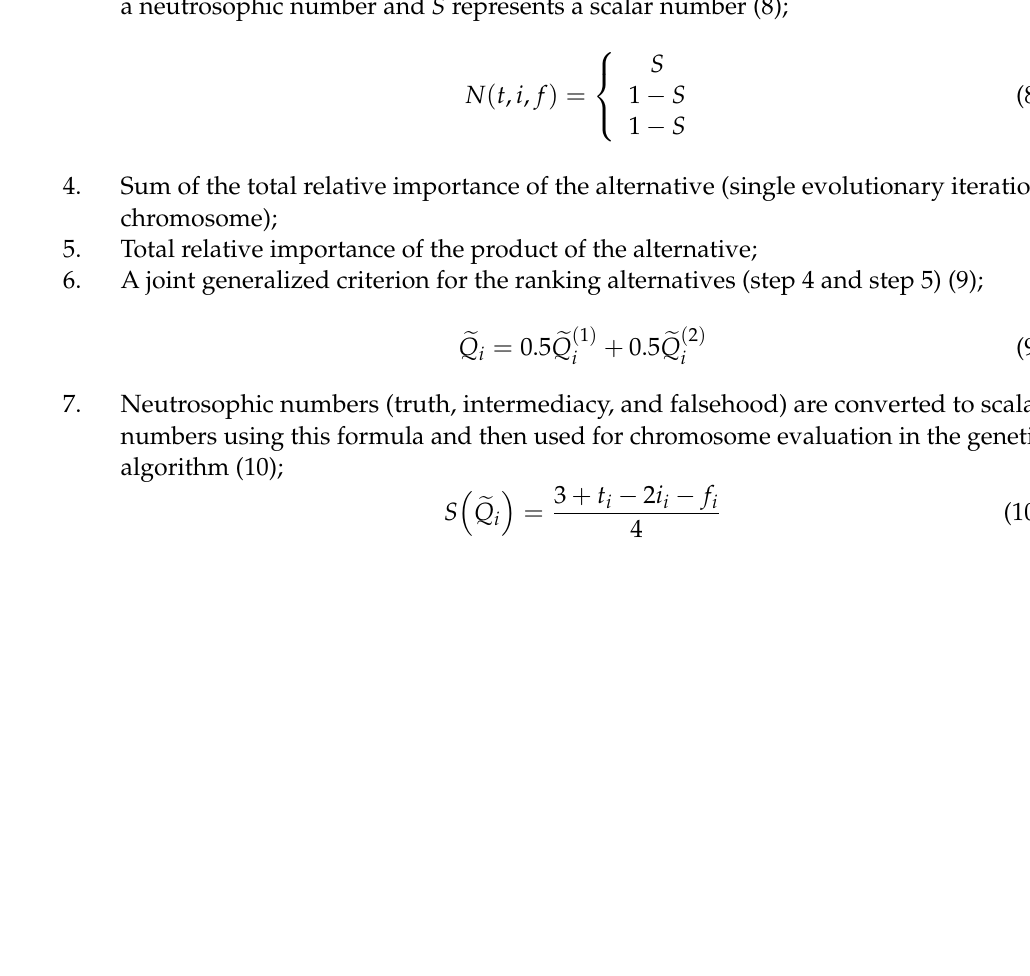
3. Neutrosophication step. In this step, we convert results from our normalized criteria function results into neutrosophic sets. The neutrosophic set consists of three numbers: truth ( t ), intermediary ( i ), and falsehood ( f ). For this, we map criteria results with neutrosophic numbers, but we do a linear conversion as even the slightest non- proportional shifts can make a huge error in the long evolutionary run. N represents